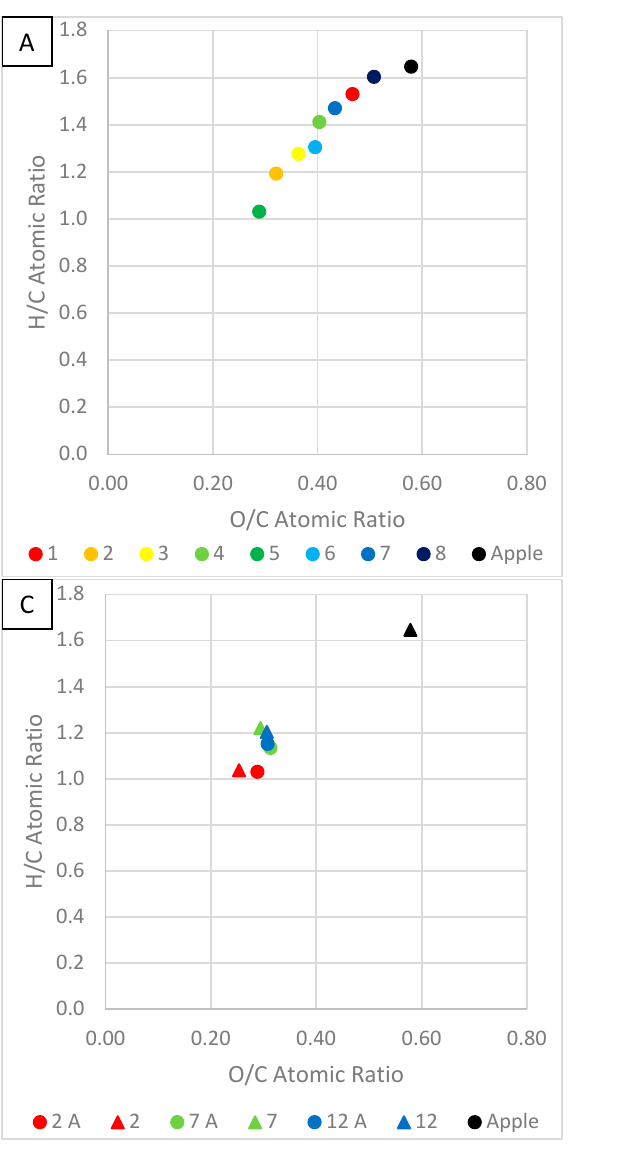
Figure 13. Van Krevalen diagrams of ( A ) HC produced under different process conditions, ( B ) HC produced using different particle sizes, ( C ) HC produced using different solution pH and acetone washing, where A signifies acetone washing, and ( D ) HC produced using different biomass feed- stocks, where ‘Aple’ is apple, ‘Wht’ is wheat, Bly is barley.